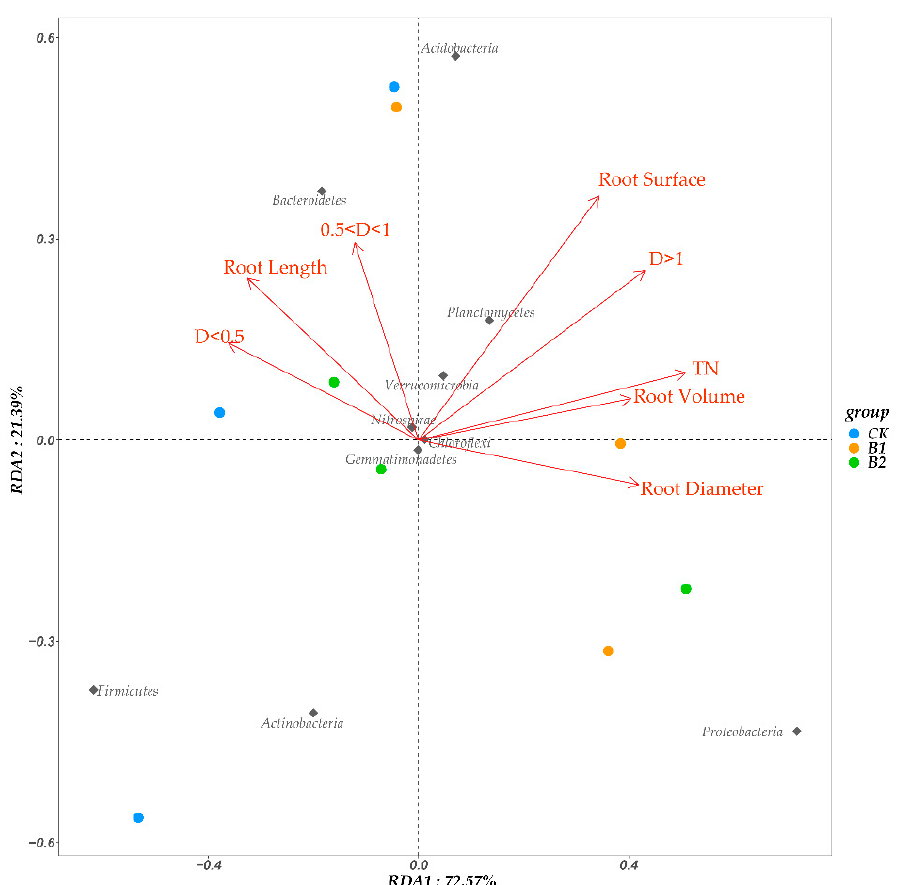
Figure 8. Redundancy analysis (RDA) of bacterial community composition (phylum level) and en ‐ vironmental variables from rhizosphere soil of maize fields without and with biochar. Abbrevia ‐ tions: D: root diameter.